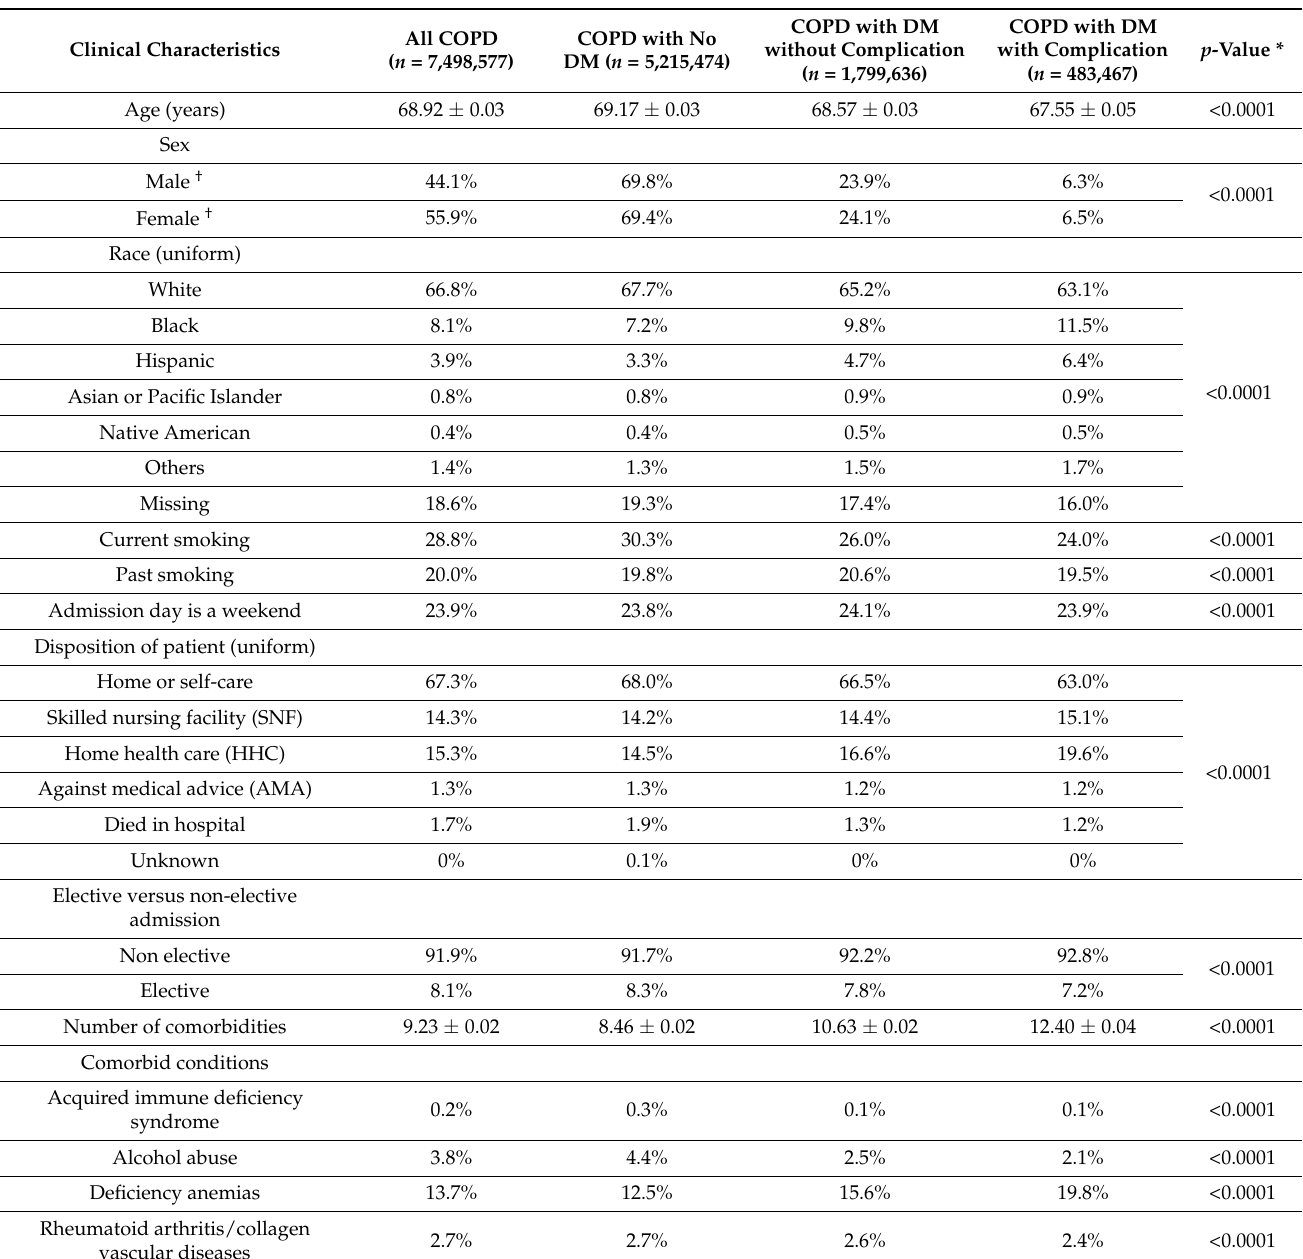
Table 1. Demographic characteristics of chronic obstructive pulmonary disease (COPD) hospitalizations with and without diabetes mellitus (DM). Clinical